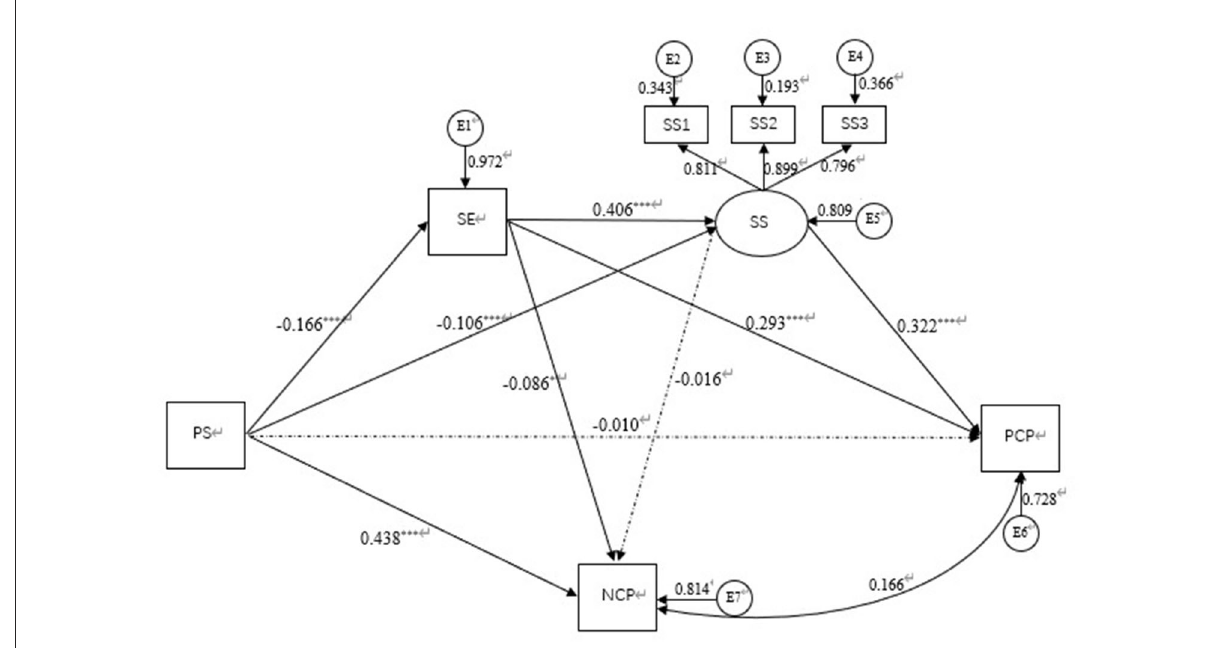
FIGURE2 Standardized relationship path diagram. PS, psychological stress; SE, self-efficacy; SS, social support; SS1, objective support; SS2, subjective support; SS3, support utilization; PCP, positive coping style; NCP, negative coping style. : * p < 0.05, *** p < 0.001.